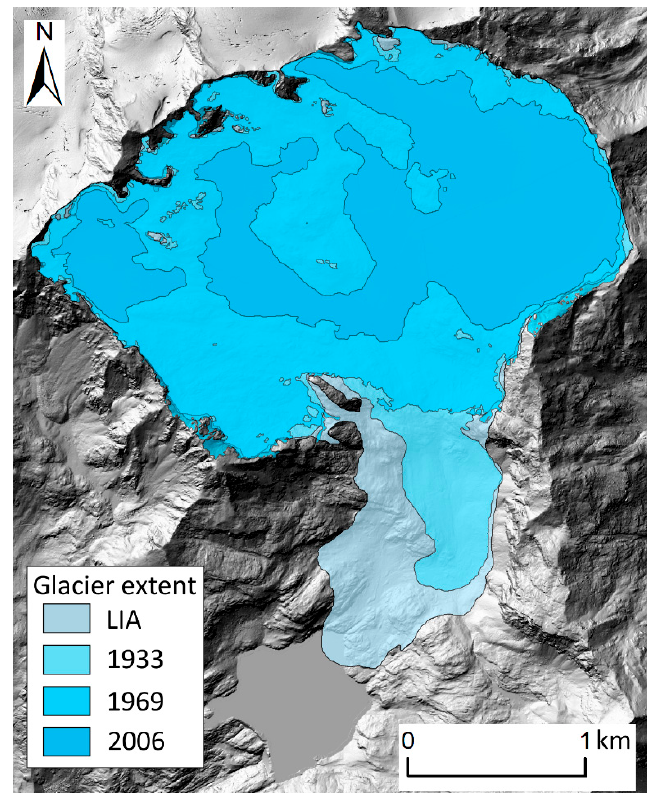
Figure 9. Careser Glacier extent in various periods since the LIA maximum [17,22,23].